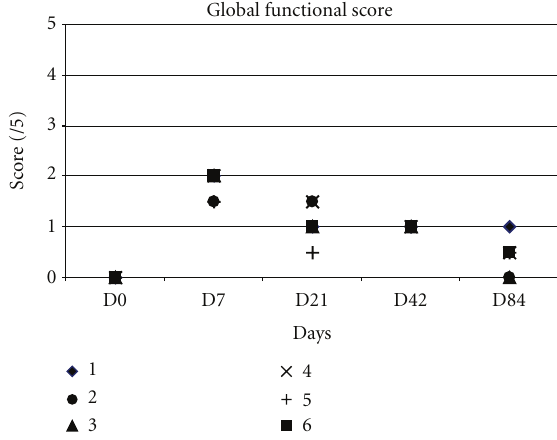
Figure 2: Pain assessment by algometer.